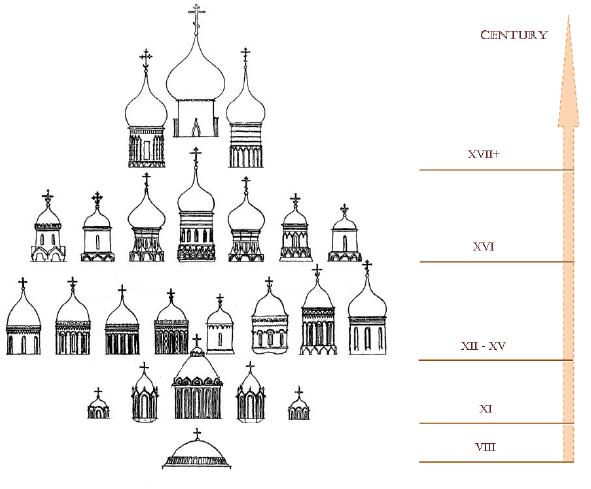
Figure 2: Forms development of cupola and crucifix.